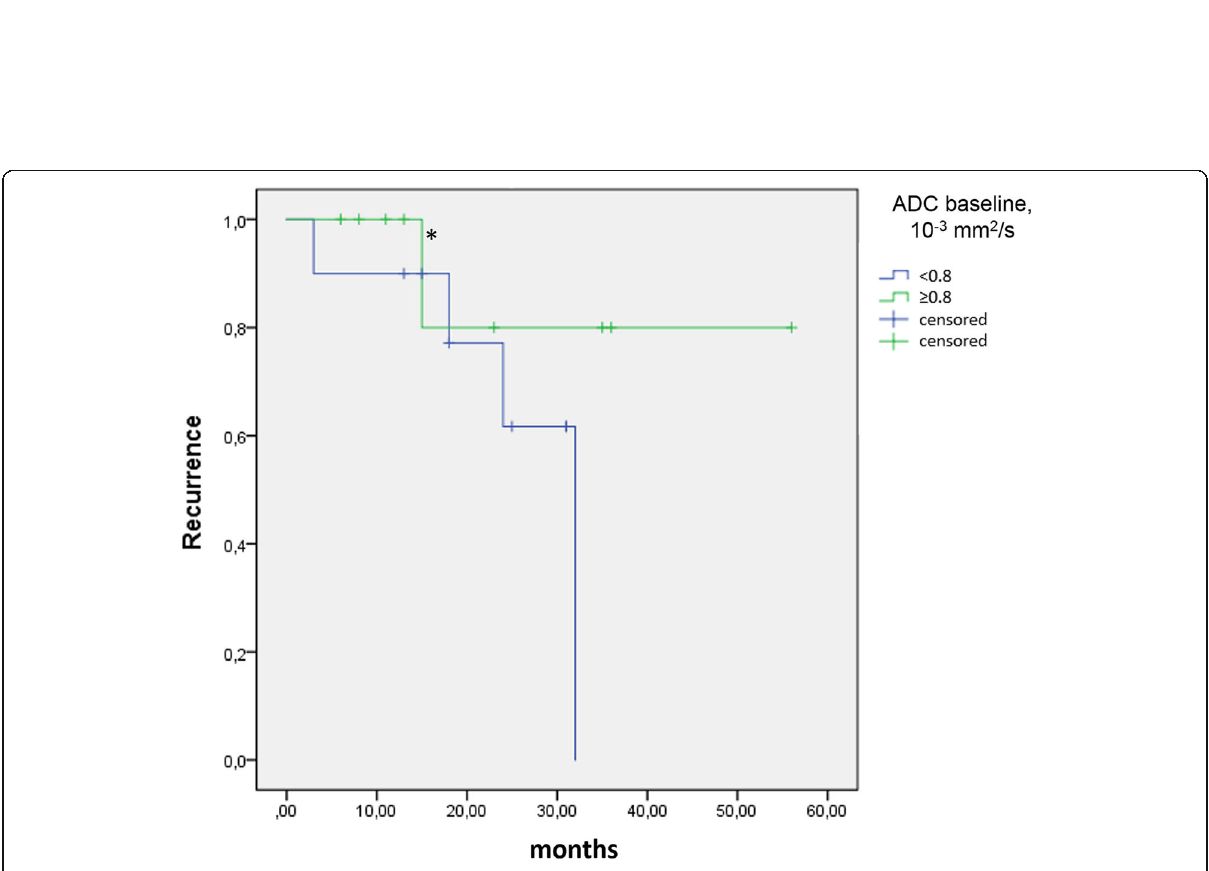
Fig. 6 Event-free survival Kaplan-Meier estimate for all patients ( n = 19) in our study using a cutoff baseline ADC ≥ 0.80 10 − 3 mm 2 /s. The initial sample size showed an ADC ≥ 0.80 mm 2 /s for nine patients and an ADC < 0.80 10 − 3 mm 2 /s in ten patients. The asterisk (*) indicates the recurrence of the malignant